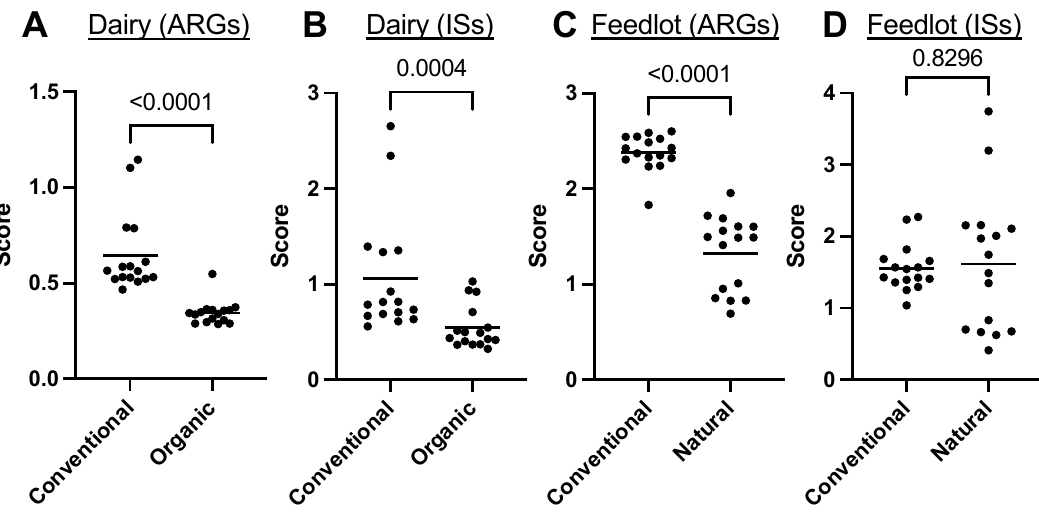
Figure 5. Quantification of ARGs ( A , C ) and ISs ( B , D ) for dairy cows ( A , B ) and animals reared in a feedlot ( C , D ). p values are shown for each of the